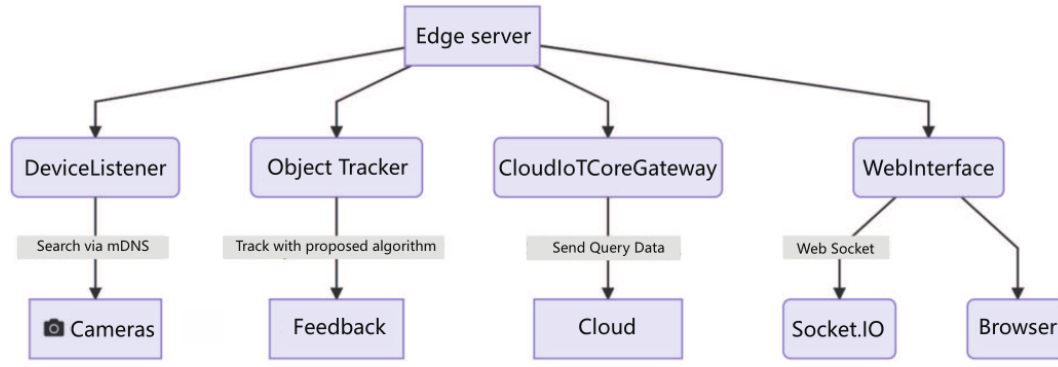
Figure 2. The project architecture of the overall